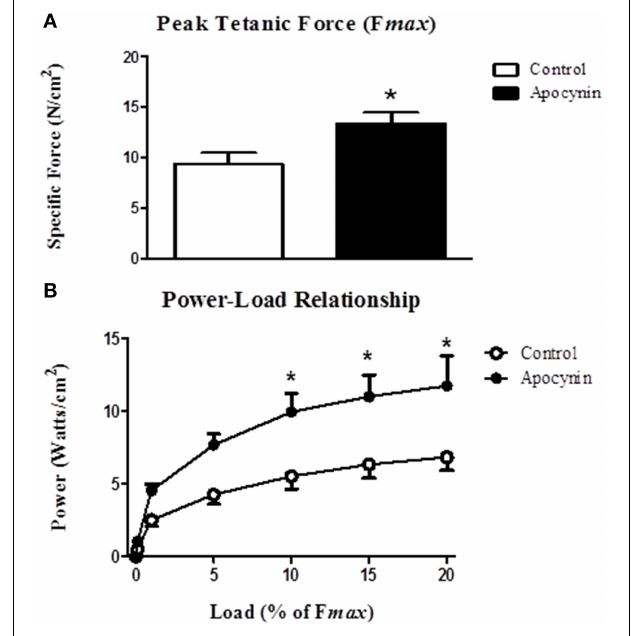
FIGURE 3 | Sternohyoid muscle aconitase and glutathione reductase enzyme activities in sham and chronic intermittent hypoxia (CIH)-exposed rats. Aconitase (A) and glutathione reductase (B) activities were significantly decreased in CIH-exposed sternohyoid muscles compared to sham controls: ∗ P = 0329 and ∗∗ P = 0 . 0046; Student unpaired t -tests. Values are mean ± SEM; n = 8 per group. Table 1 | Sternohyoid muscle contractile properties in the absence and presence of 2mM apocynin.